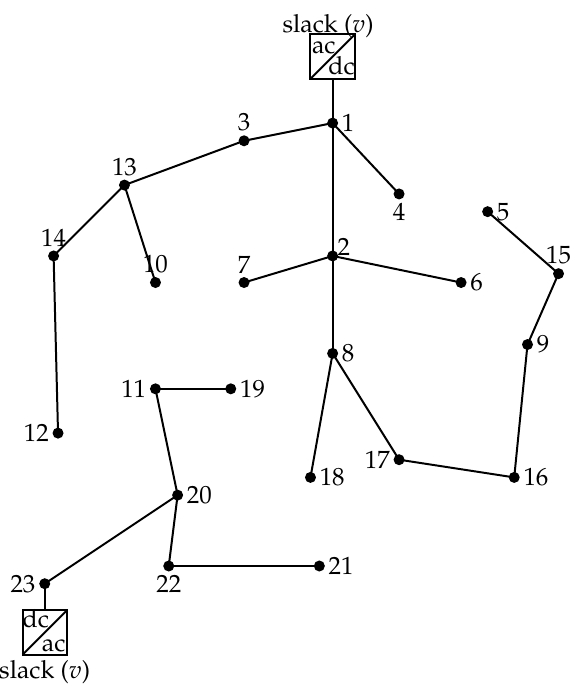
Figure 9. Electrical configuration for the 23-nodes test feeder reached for the S3 .